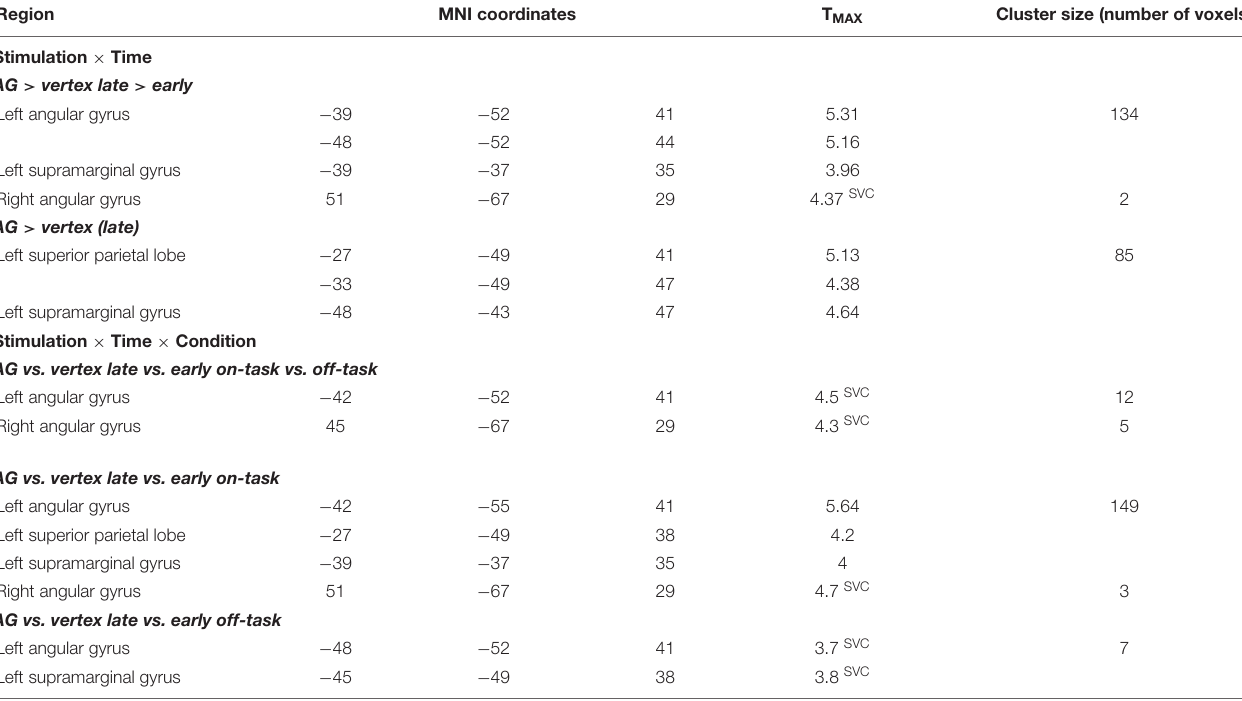
TABLE 1 | Stimulation effects on brain activity. Region MNI coordinates T MAX Cluster size (number of